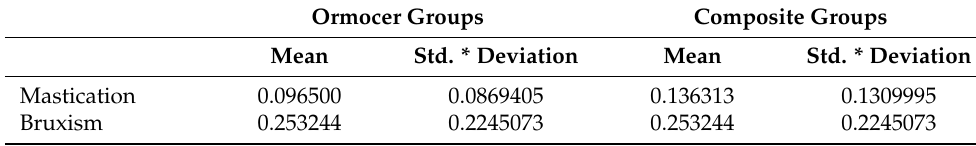
Table 2. Group’s descriptive statistics.